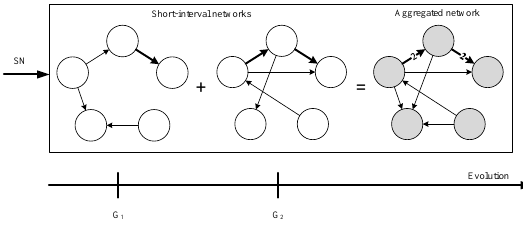
Fig. 3: Illustration of the aggregated network creation on the basis of the DE algorithms